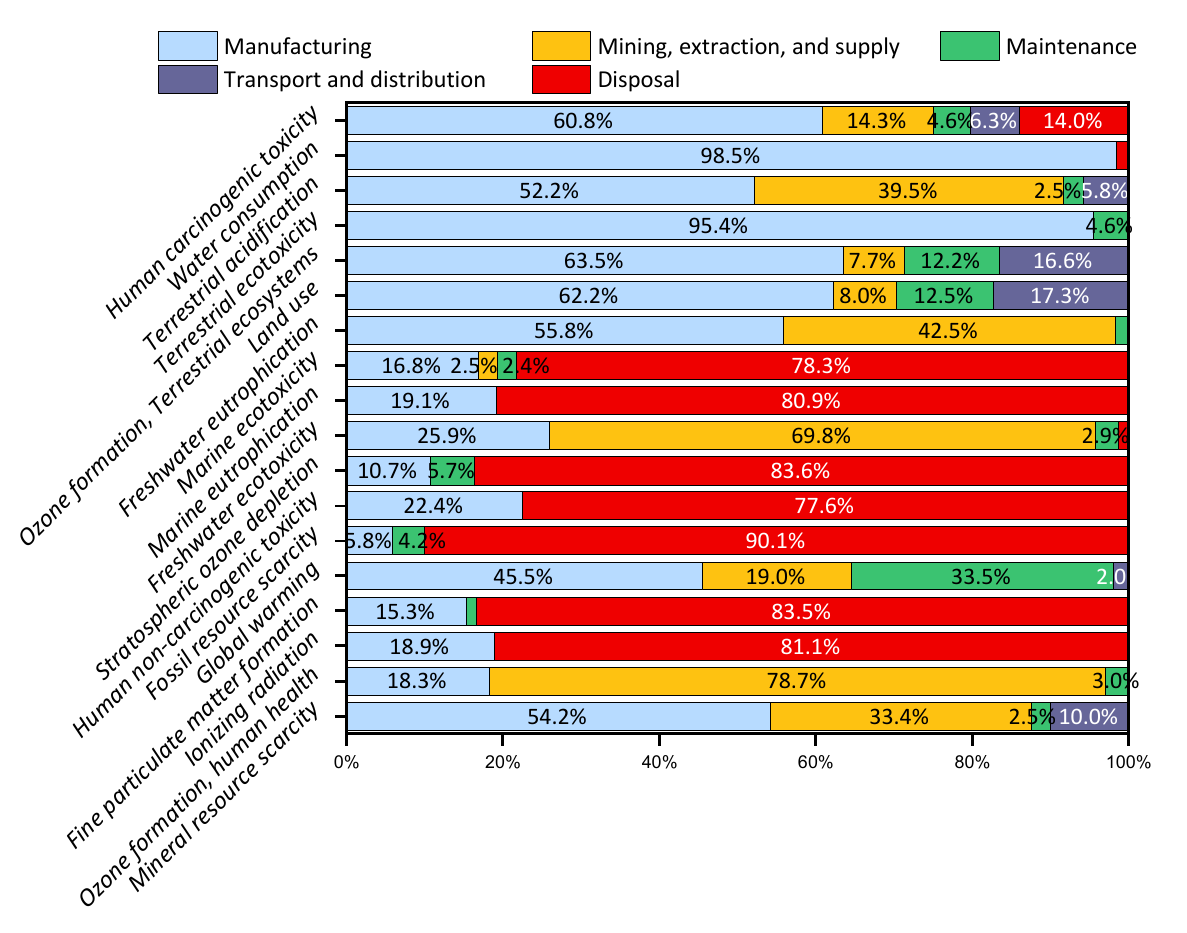
Figure 7. The shares of different procedures on the environment during the operation of the 246.02 kWh charging station. Table 9. The comparison between different types of input fuel for the SOFC stacks and their impacts on the environment based on ReCiPe 2016 v1.03 Midpoint (H) for the suggested design of the 246.02 kWh charging